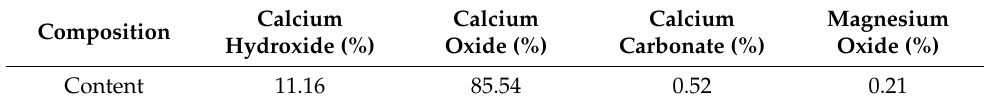
Table 2. Lime composition.